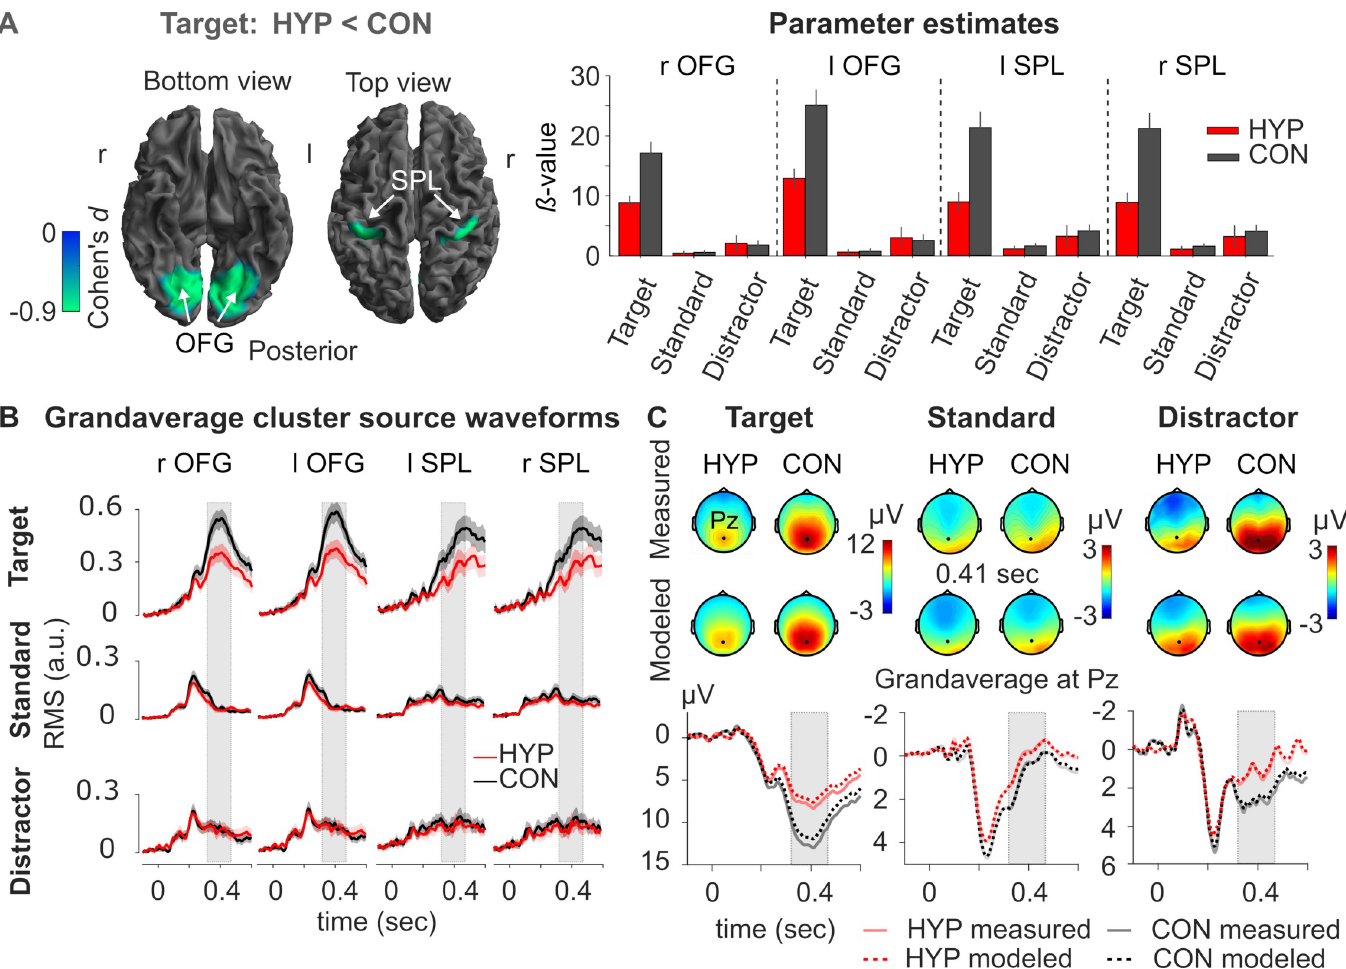
Fig 4. Effect of hypnosis at source-level. (A) Effect size ( Z 2 ) of statistical comparison ( t -contrast) of hypnosis (HYP) vs. control (CON) for the processing of the target p stimulus. Left panel: The cortical mesh images show sources that were significantly less activated in HYP compared to CON following processing of target. SPL = superior parietal lobule; OFG = occipital fusiform gyrus. The summary statistic images of the cortical mesh were thresholded at uncorrected p = .001 with FWE correction at cluster-level, p = .05, based on random field theory. r = right, l = left. Right panel: The bar plots summarize the contrast estimates (90% C.I.) for three stimulus types in HYP and CON at the respective peaks of the cluster. (B) The grandaverage cluster source waveforms (across participants, n = 60) and 95% C.I. are based on the average of source waveforms within the respective clusters found in Fig 3A (see S1-11 Table in S1 File) for the three stimulus types in HYP (red) and CON (black). Source strength is expressed as root mean square (RMS, in arbitrary units). Grey rectangle marks the P3b window (320–470 ms). (C) Comparison between modeled (dotted lines) grandaverage data, i.e., all back-projected sources, and measured (solid line) grandaverage data in sensor space at electrode Pz for three stimulus types in HYP (red/pink) and CON (black/grey). Note that back-projected model data at sensor-level (modeled data) match very well the measured data profiles as indicated by grandaverages at Pz and the scalp topographies at 0.41